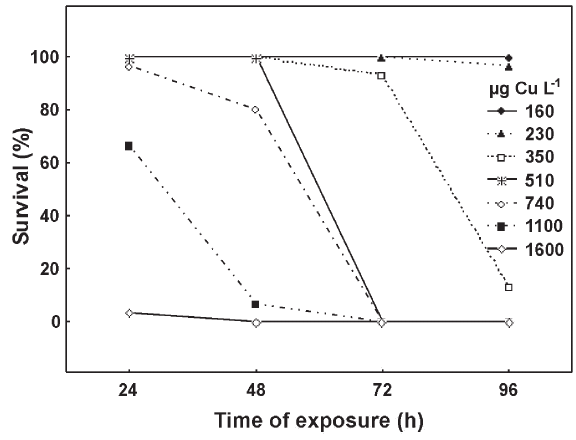
Fig . 1. – Survival (%) of Zoea I of Lithodes santolla exposed to